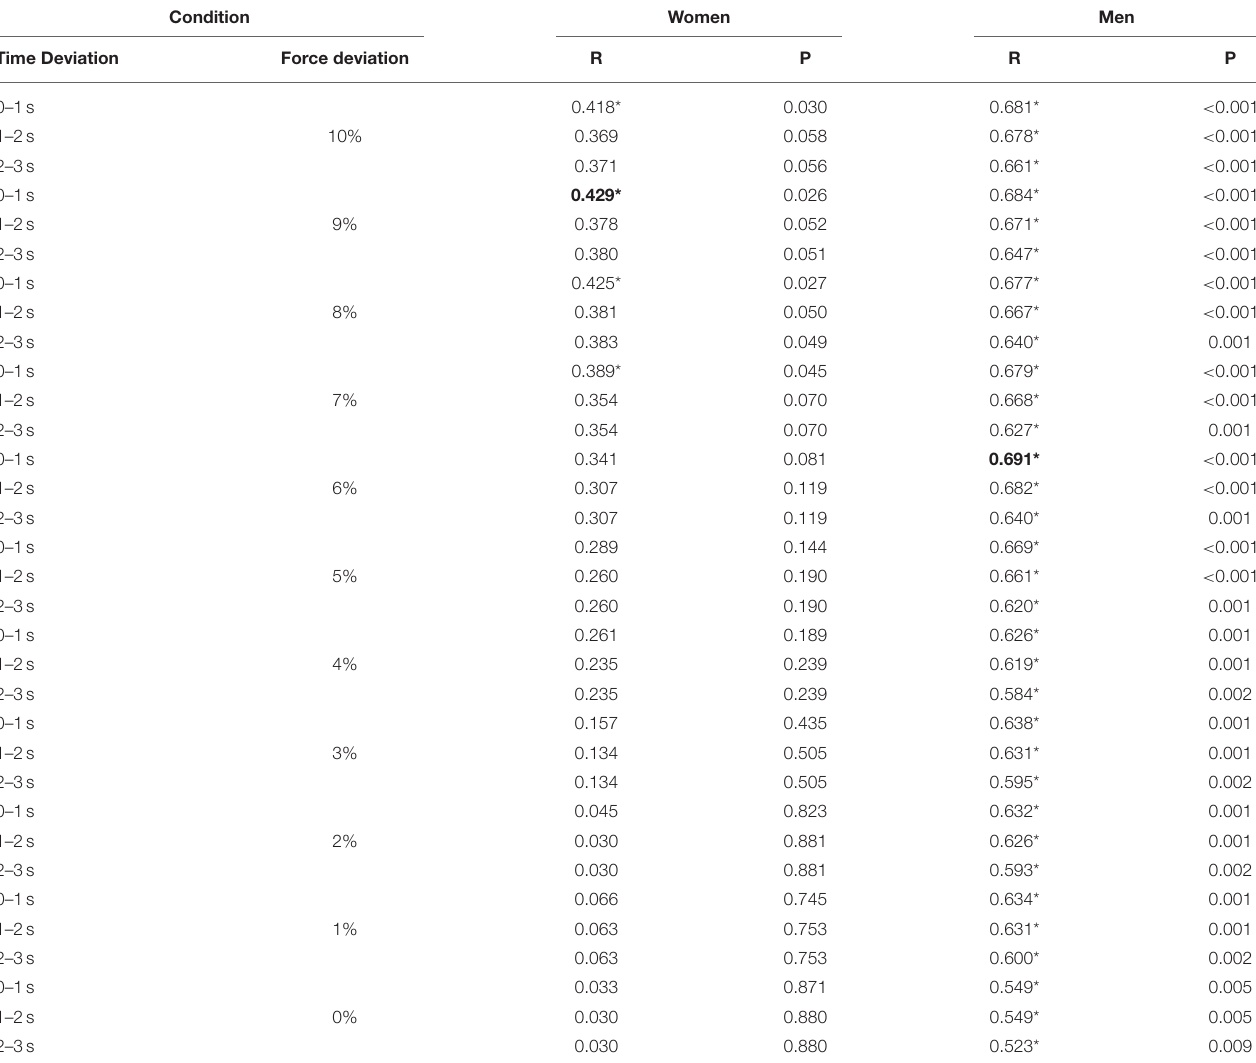
TABLE 6 | Results of the correlations of the intermittent finger flexor muscle endurance test with lead climbing performance for different tolerated deviations of time and force.